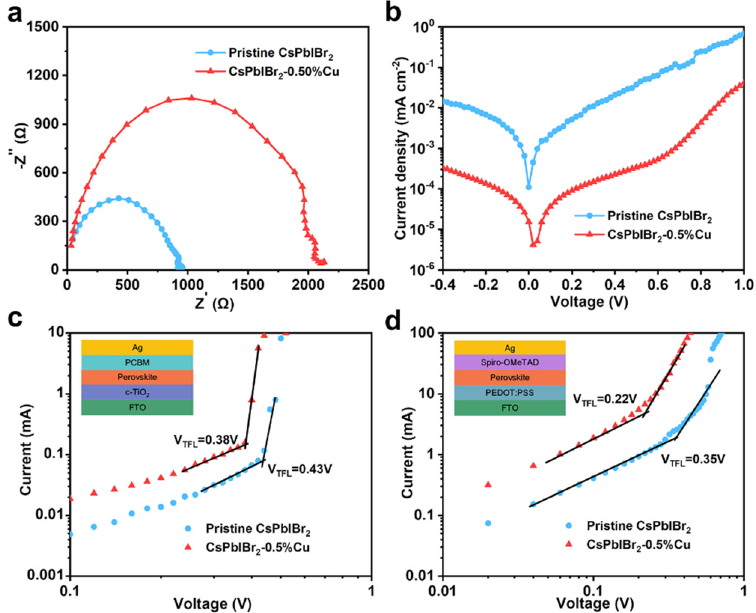
Figure 4. ( a ) EIS spectra and ( b ) J − V curves of CsPbIBr 2 and CsPbIBr 2 -0.50%Cu cells in the dark. Dark J − V curves of ( c ) electron-only and ( d ) hole-only PSCs based on CsPbIBr 2 and CsPbIBr 2 -0.50%Cu. Hole-only and electron-only PSCs with structures of FTO/PEDOT:PSS/pervoskite/ Spiro-OMeTAD/Ag and FTO/TiO 2 /pervoskite/[6,6]-phenyl-C61-butyric acid methyl ester (PCBM)/Ag were prepared to determine the trap densities of PSCs by measuring the dark J − V curves using the space charge-limiting current model [13,79]. As shown in Figure